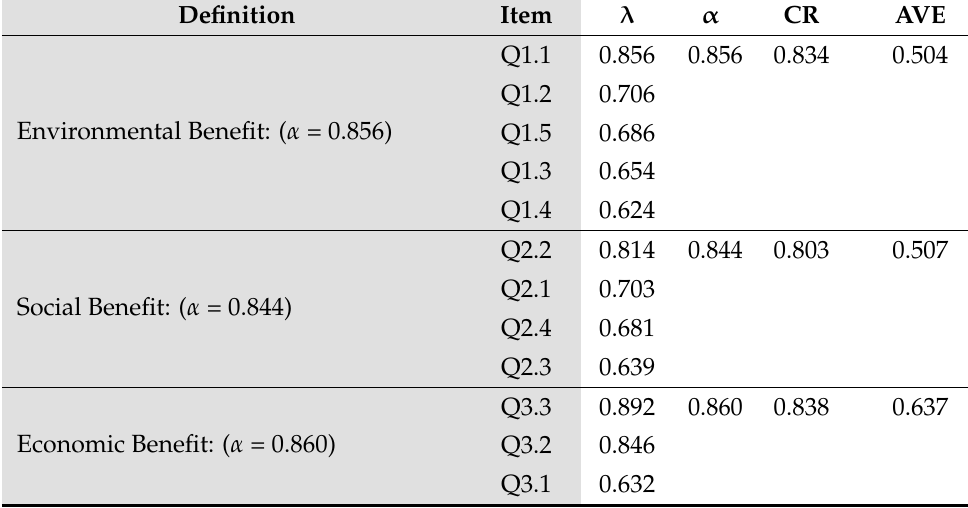
Table 5. KFA, Cronbach α , CR, and AVE results of 5-point Likert